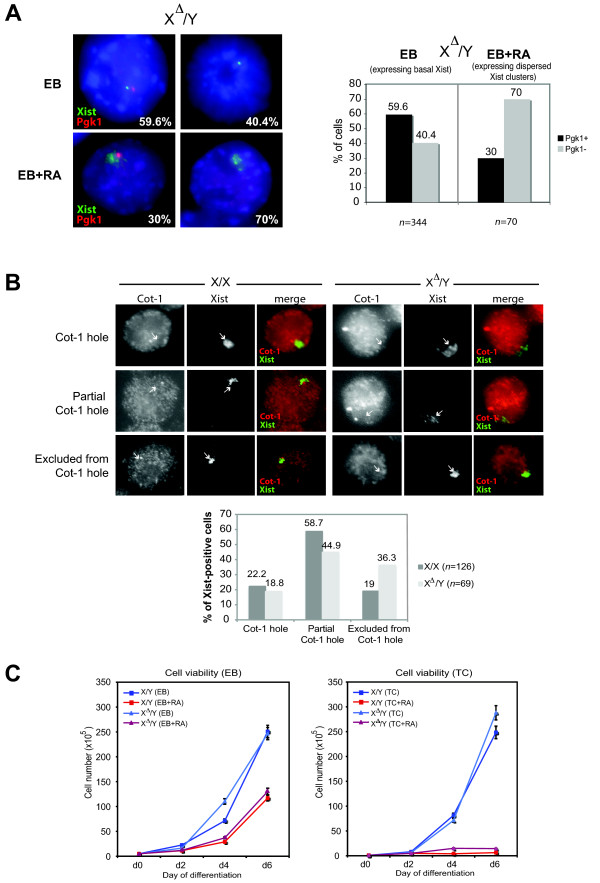
RA-containing cultures lead to silencing of the X-linked gene Pgk1 and exhibit slower overall growth than cultures without RA. A. Xist/Pgk1 RNA FISH showing the percentage of Pgk1 expression in XΔ/Y cells differentiated under the EB or EB+RA condition at day 6. EB+RA percentages represent only those cells positive for dispersed Xist RNA clusters. EB percentages represent all cells expressing basal Xist levels. B. Xist/Cot-1 RNA FISH of X/X (EB) and XΔ/Y (EB+RA) with Xist RNA clouds at day 6. Percentages represent Xist+ cells that were scored to be located within a Cot-1 RNA hole, partially within a Cot-1 hole, or excluded from a Cot-1 hole, as indicated. Note the higher percentage of Xist clouds excluded from a Cot-1 hole in XΔ/Y cells when compared to X/X cells. Arrows point to Xist clouds/clusters and their corresponding Cot-1 regions. C. Growth curves for wild-type and Tsix-mutant male cells differentiated under EB/EB+RA (left) or TC/TC+RA (right) conditions. Cultures containing RA (denoted in shades of red) had <50% of cells than those cultures grown in the absence of RA (denoted in shades of blue). No differences were seen between X/Y and XΔ/Y grown under similar conditions. Error bars represent one standard deviation from the mean; days of differentiation are listed as day 0 (d0), day 2 (d2), day 4 (d4), and day 6 (d6).